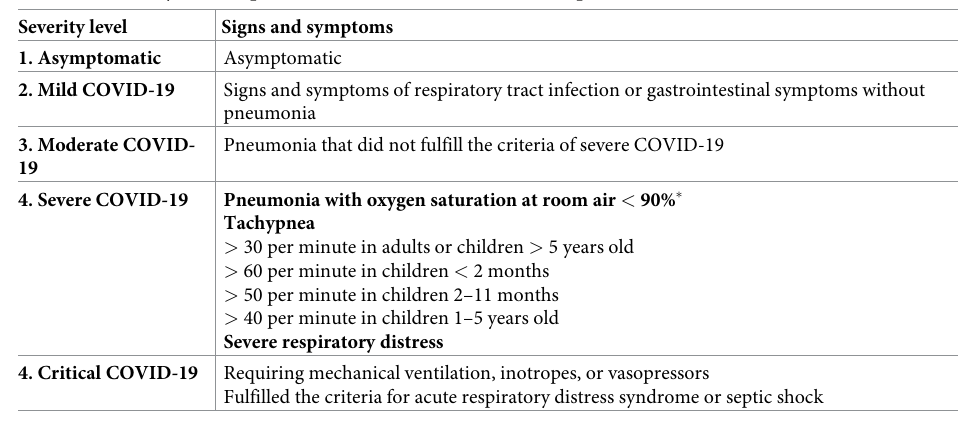
Table 1. A severity level for patients with COVID-19 infection; Adapted from reference no